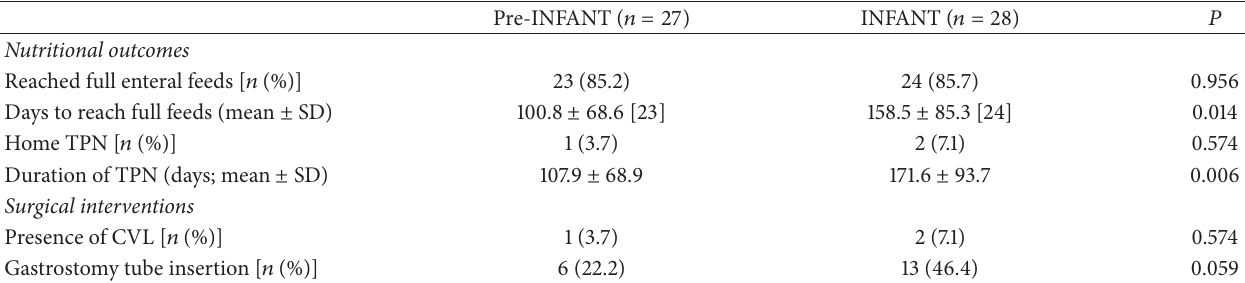
Table 2: Nutritional outcomes and surgical interventions of patients with